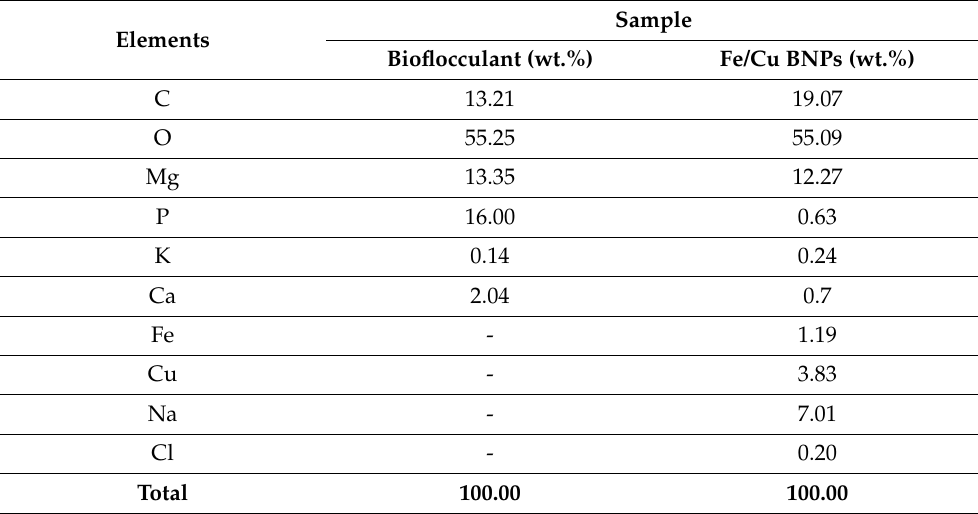
Table 2. Elemental composition of the bioflocculant and nanoparticles.